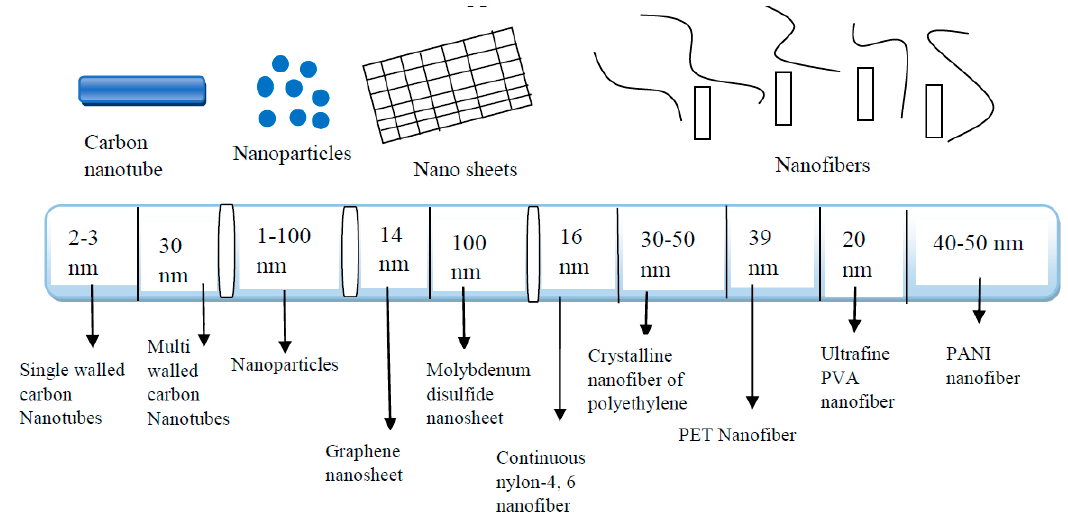
Figure 1. Schematic representation of different nanomaterials and their diameters. Carbon nanotubes are known to have diameters in the range of a nanometer. Nanoparticle properties change as it gets to nanoscale. The nanosheet is regarded as another type of nanoparticle. Nanofibers can be prepared from diverse polymers and hence, have diverse sizes.